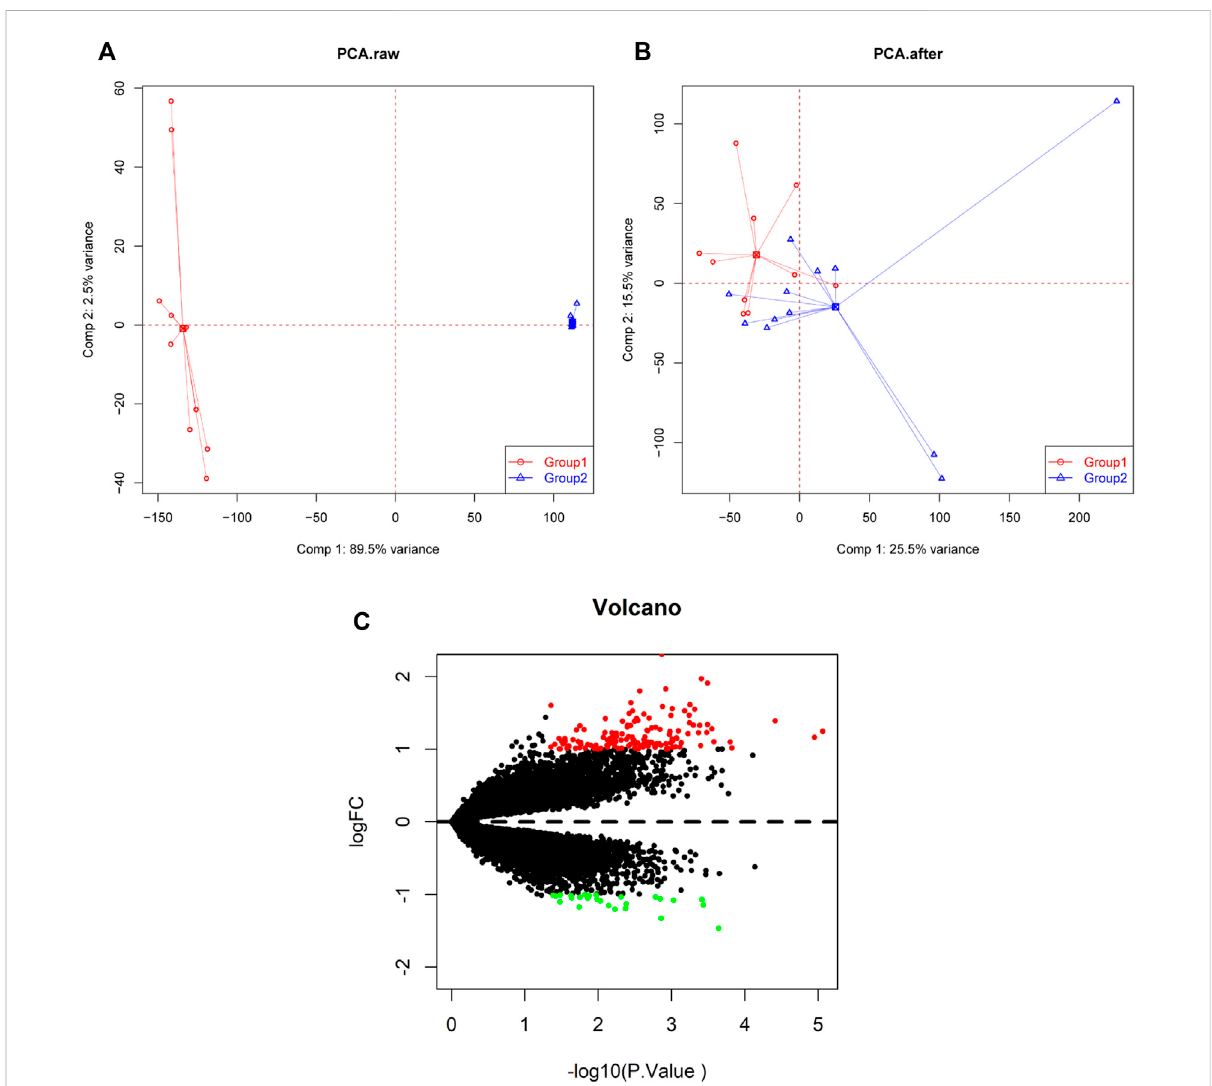
FIGURE 1 PCA cluster plot before and after batch effect adjustment and volcano plot of DEGs. (A) PCA cluster plot of the GSE34526 and GSE137684 datasets without batch effect adjustment. (B) PCA cluster plot of the GSE34526 and GSE137684 datasets with batch effect adjustment. (C) Volcano plot of DEGs between PCOS and normal samples; red shows upregulated DEGs, black shows no signi fi cant DEGs, and green shows downregulated DEGs. PCA, principal component analysis; DEGs, differentially expressed genes; PCOS, Polycystic ovary